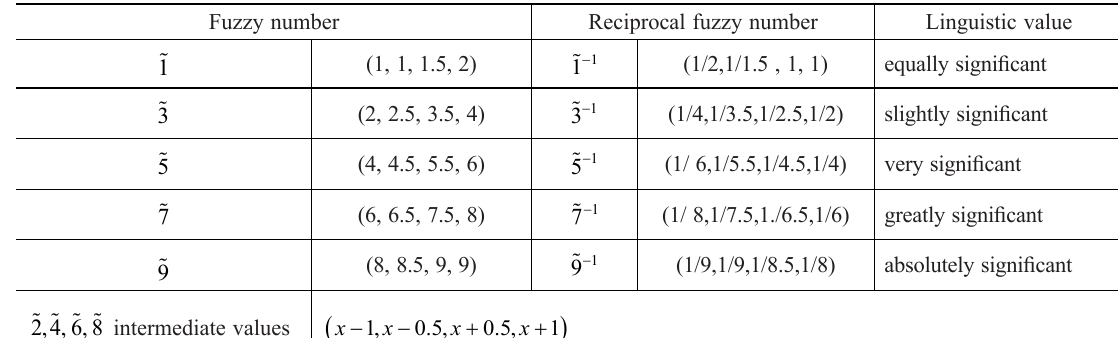
Table 1. Rating scale for measuring mutual importance of criteria or alternatives